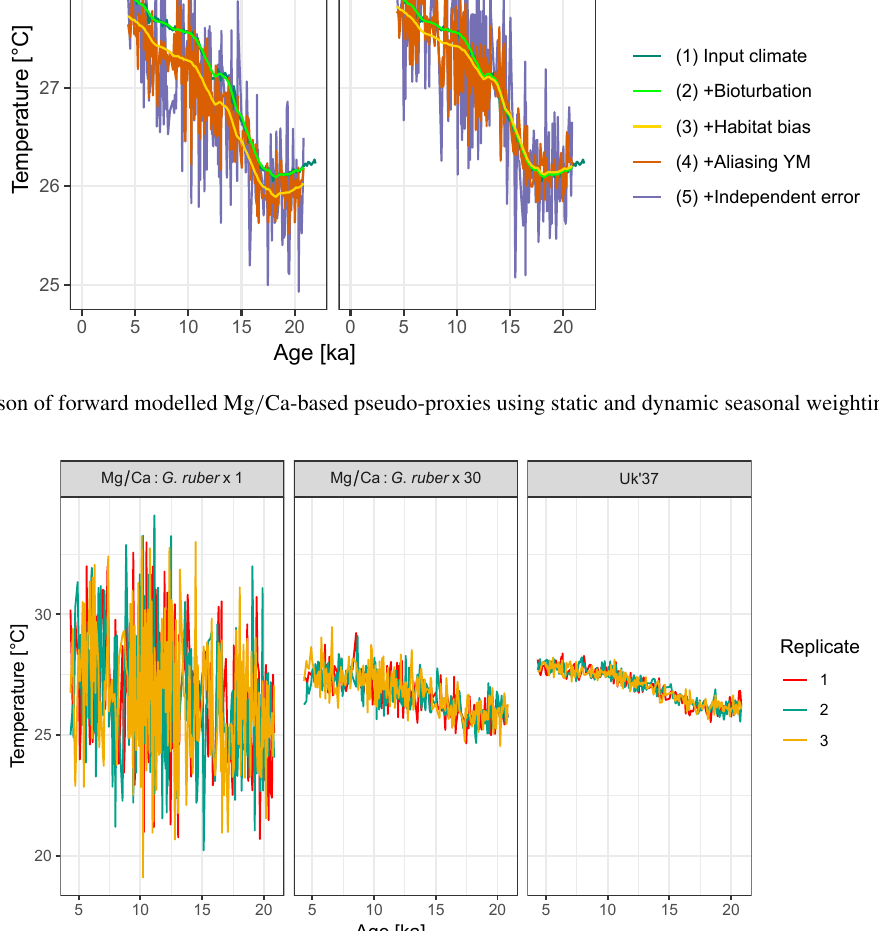
(cid:48) . Three replicate 37